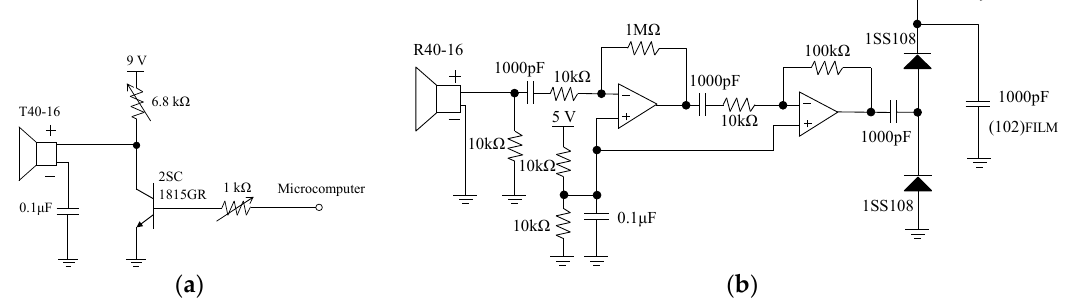
Figure 2. Circuit configuration for ultrasonic sensor: ( a ) Transmission portion; (b ) Reception portion.